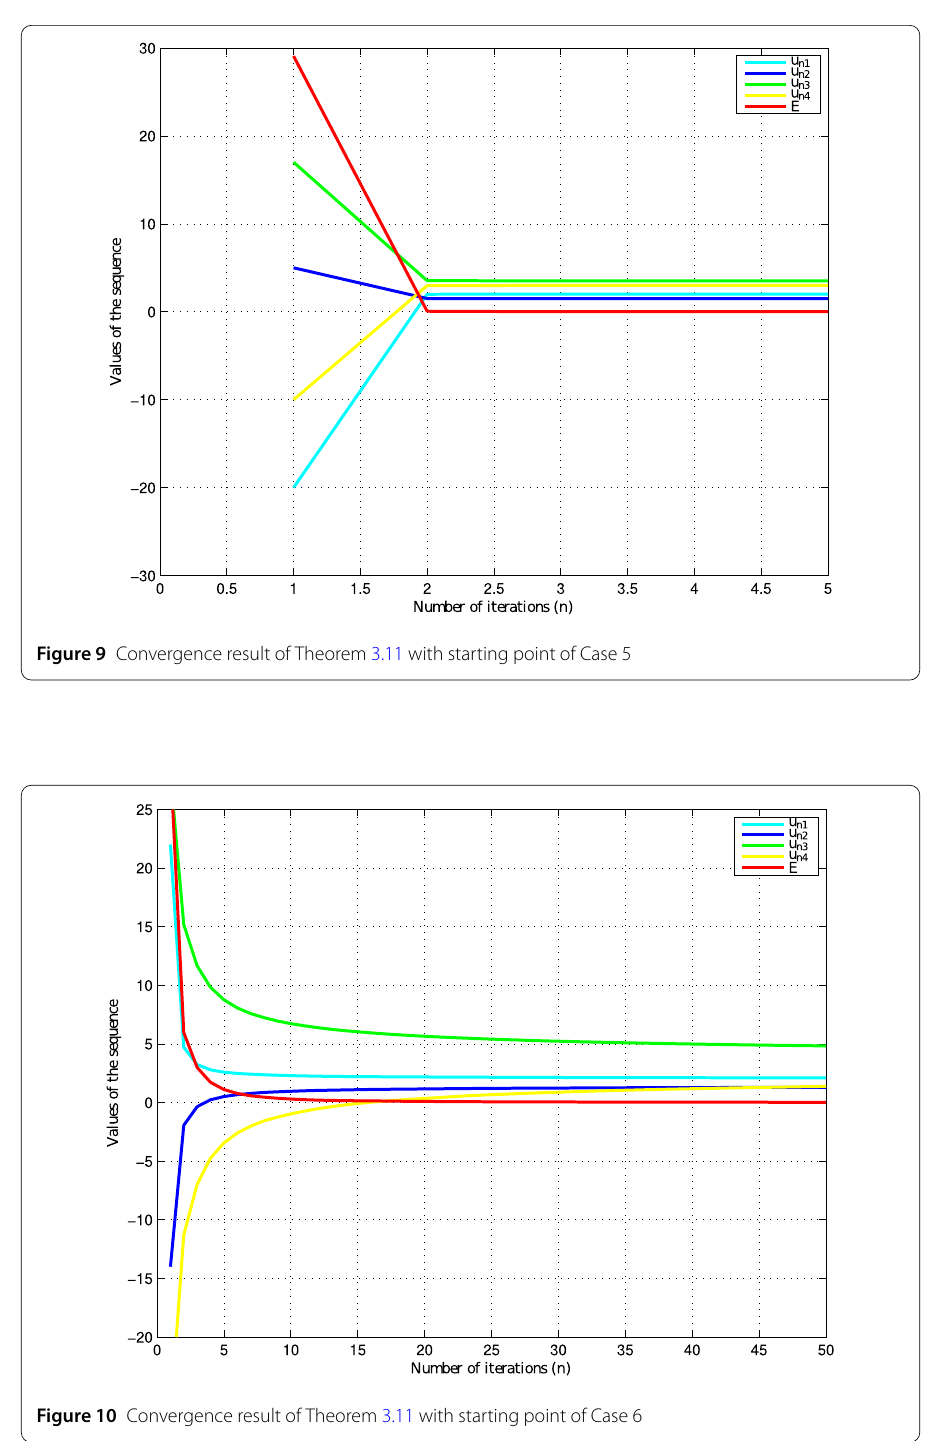
ery i . Now, using Case 5: u 1 = (–20,5,17,–10), Case 6: u 2 = (22,–20,–19,30), Case 7: u 1 = (23,–30,–28,24), and case 8: u 1 = (27,–20,–19,30), we have Figs. 9–12 due to Theo- rem 3.11. Also, Table 2 displays the approximate values of few terms of the sequence { u n } in Example 4.2 using the starting points of Case 5 and Case